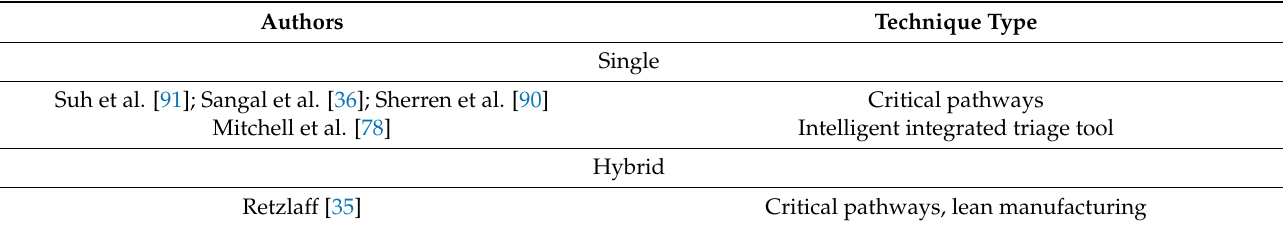
Table 5. Papers demonstrating the design and implementation of healthcare protocols for augmenting the emergency department response to the COVID-19